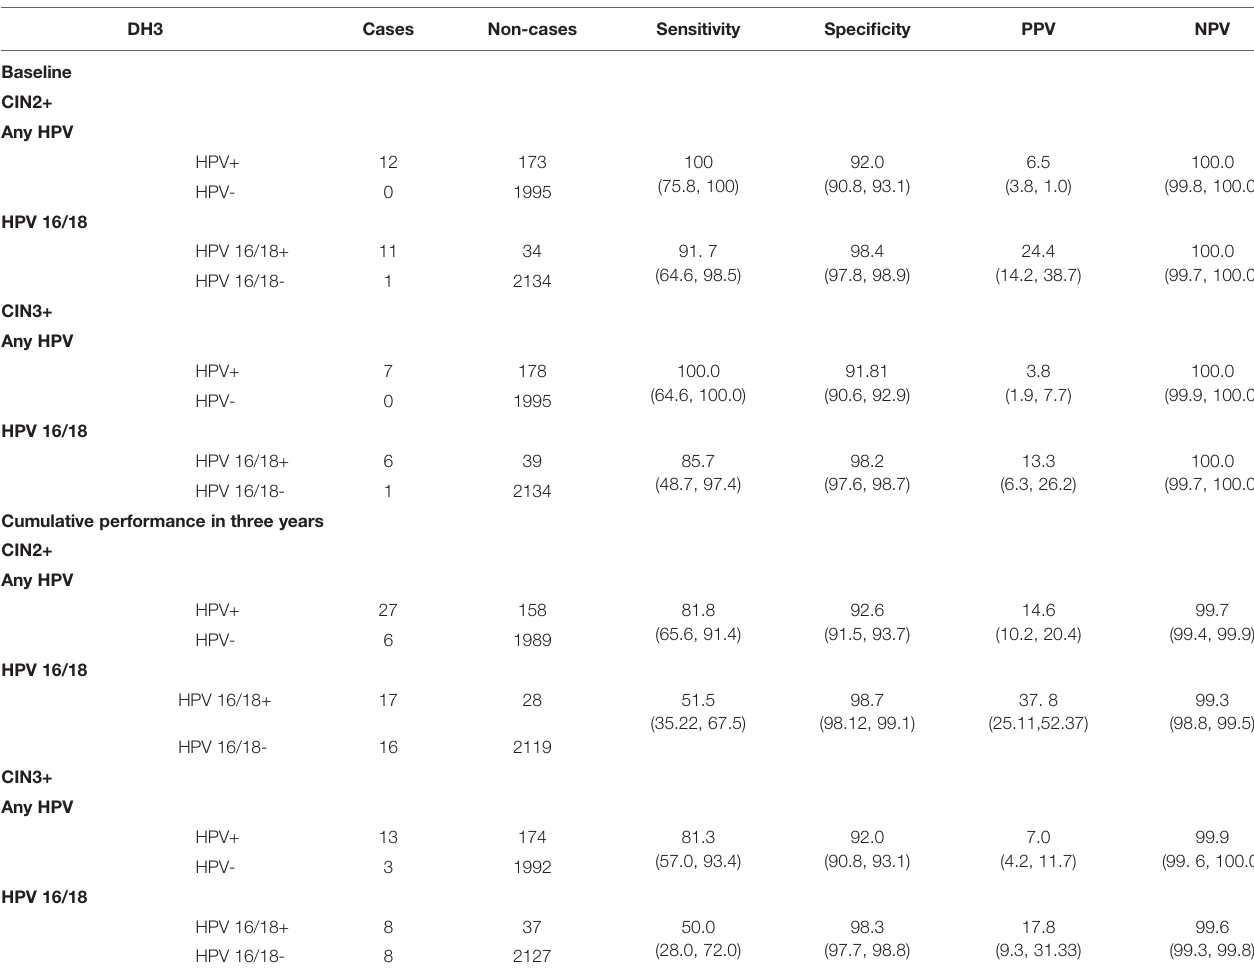
TABLE 2 | Performance of DH3 HPV assay in cervical cancer screening. DH3 Cases Non-cases